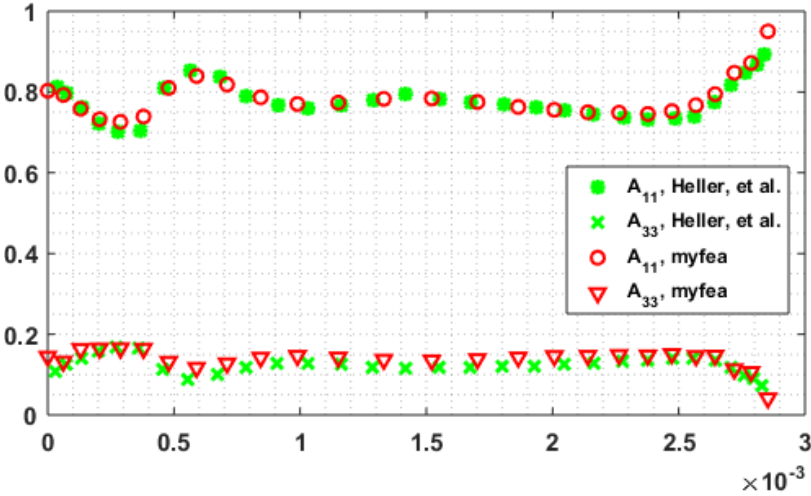
Figure 10. Fiber orientation diagonal components at the flow end.